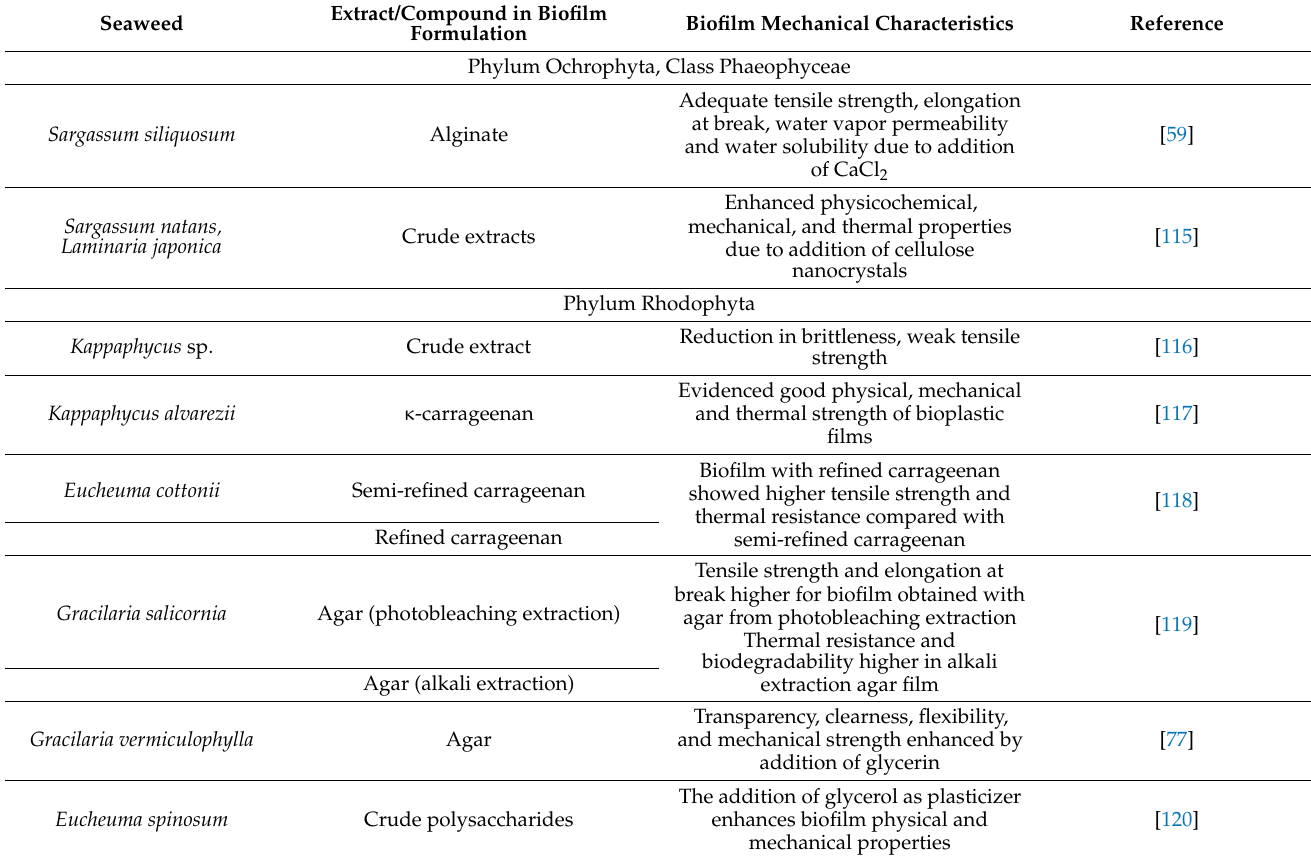
Table 1. Seaweeds investigated for the development of biofilms for packaging manufacture. Extract/Compound in Biofilm Seaweed